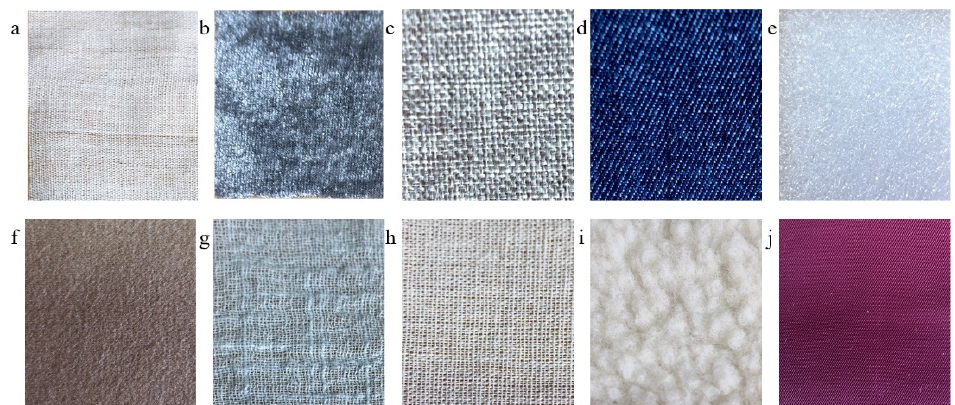
Figure 3. Photograph of ten materials tested: ( a ) polyester; ( b ) flannel; ( c ) asamoto; ( d ) denim fabric;